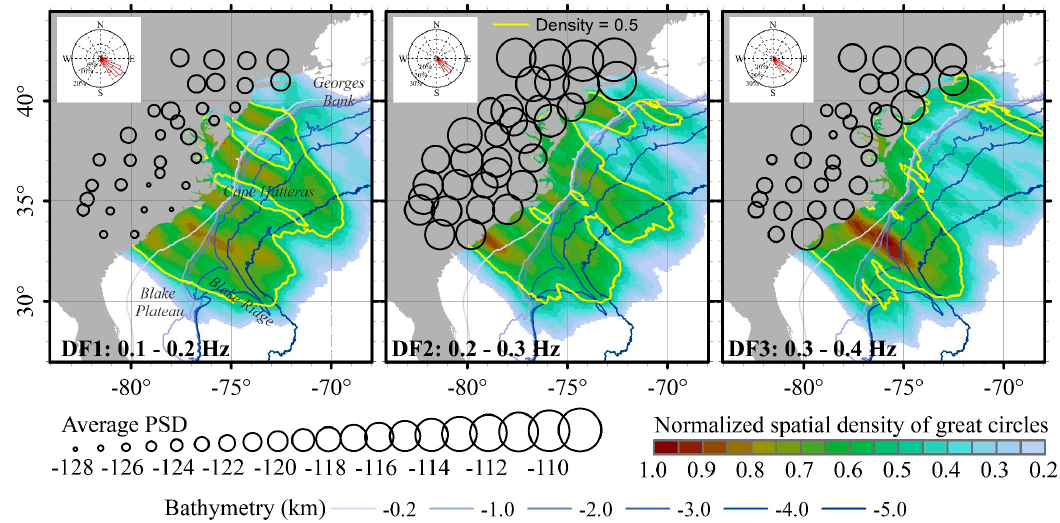
Figure 3. The normalized spatial density (color gradient maps) of the great circles corresponding to the daily primary vibration directions ( ϕ m 1 ) and the vertical PSDs averaged for the entire recording period (scaled circles) in the three DF bands. The yellow lines contour the density of 0.5. The rose diagram shows the probability distribution of all ϕ m 1